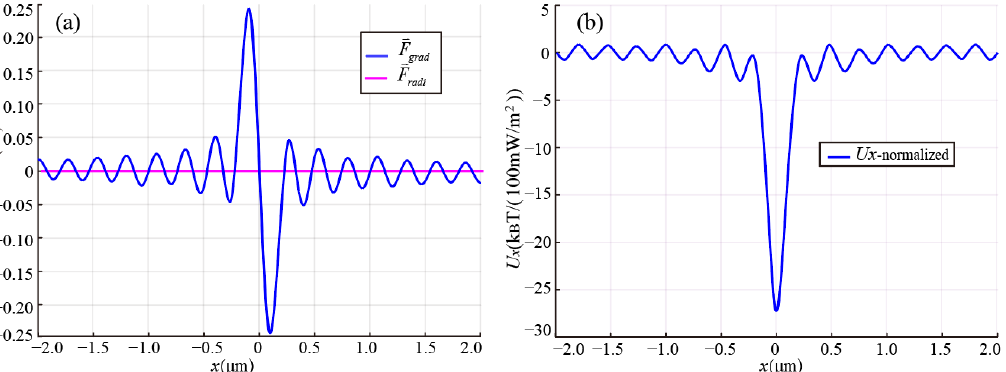
Figure 5. The distribution of ( a ) light force and ( b ) trapping potential of the small ball in the radial direction.